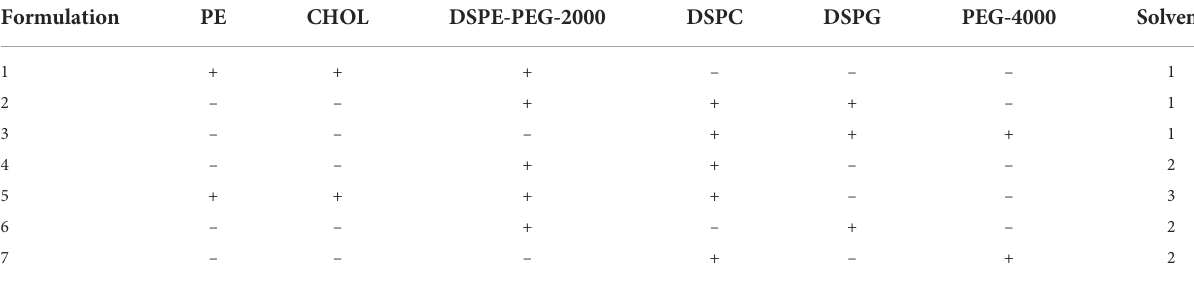
TABLE 1 Seven different formulations for ultrasound contrast agent